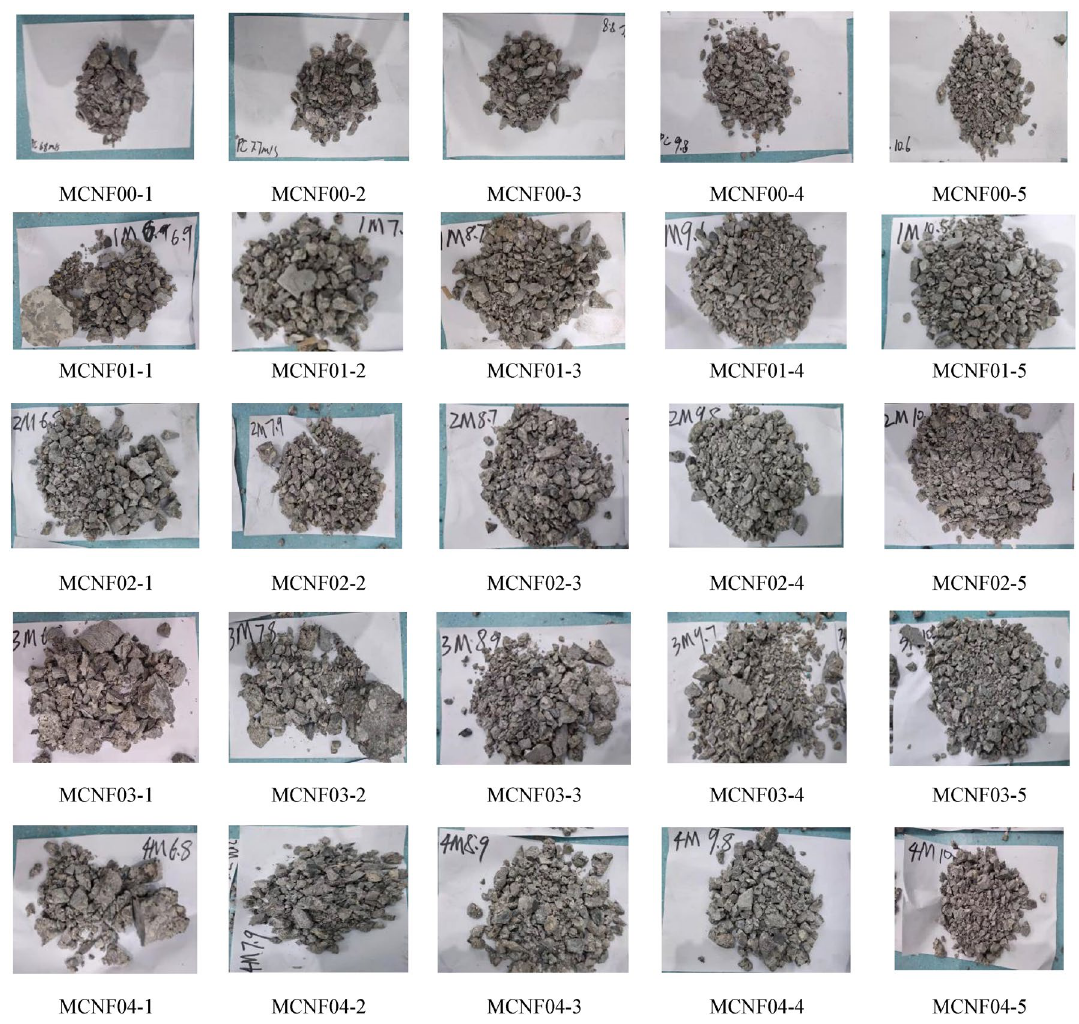
Figure 5. The failure patterns of MCNF concretes under different impact